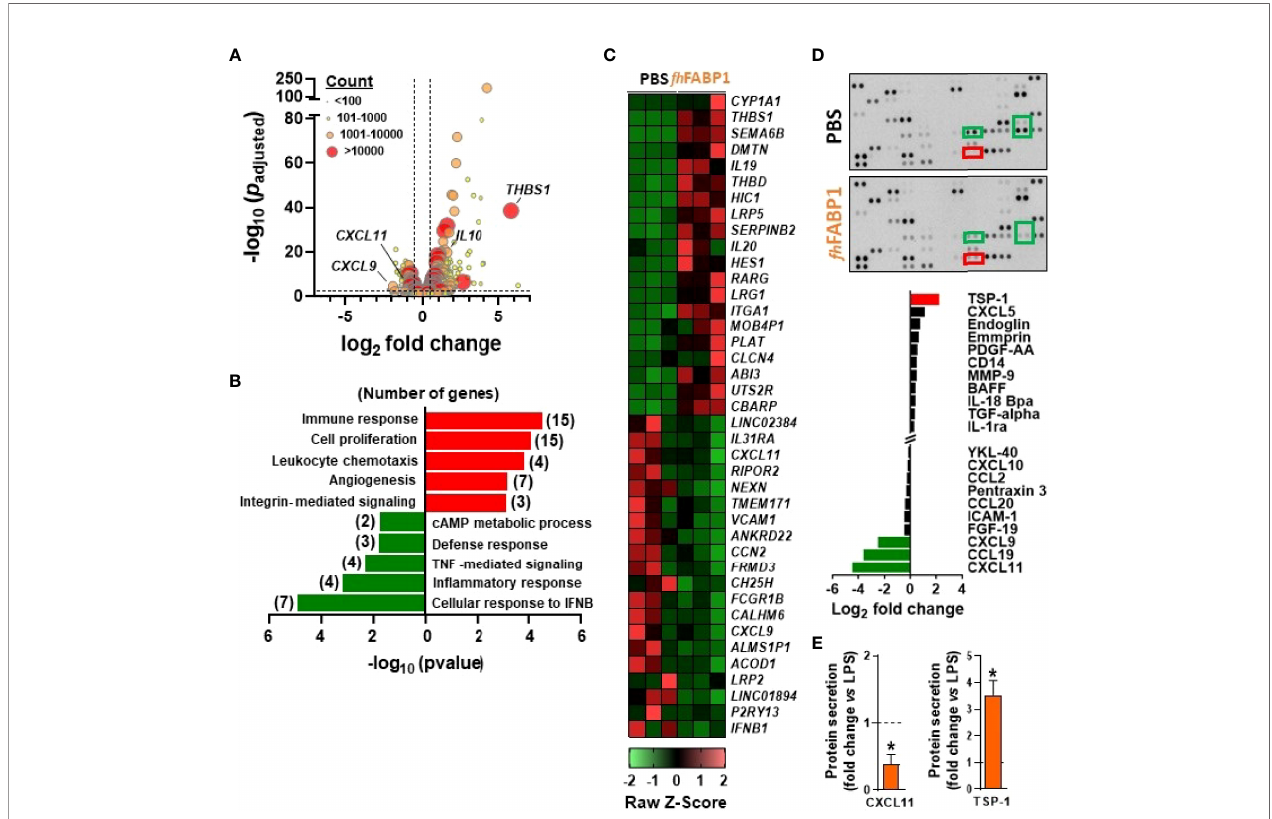
FIGURE 5 | Fasciola hepatica FABP1 promotes thrombospondin expression and secretion by dendritic cells Human monocyte-derived DCs (moDCs) were treated with or without recombinant fh FABP1 (25 µg/ml) for 5 h (A – C) or 48 hours (D, E) in the presence of LPS (100 ng/ml) RNAseq was performed in 5h-conditioned moDCs (n=3 independent experiments) and the differentially expressed genes (DEGs) are visualized on a volcano plot using DESeq2 normalized transcript counts (A) Gene ontology analysis was performed on the up and down DEGs (B) The top 20 up and down DEGs are shown on the heat map (C) Proteomic analysis of the moDCs secretome was performed in LPS-stimulated moDCs treated with or without recombinant fh FABP1 for 48 hours using the Proteome Pro fi ler Cytokine Kit (D) The effects of fh FABP1 on secretion of CXCL11 and thrombospondin (TSP-1) by moDCs were con fi rmed by ELISA (E) and the data are expressed relative to the moDCs stimulated with LPS alone (dash line) as mean ± SEM * P ≤ 005 vs LPS alone (n=3-5 independent